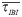
Three different types of SBs at different DIVs.Structures of FRTH at (a) 6 DIV, (b) 9 DIV and (c) 22 DIV. The mean inter-burst interval (τIBI¯) are also shown in the figures. The insets are the FRTHs of another SB in the same recording.